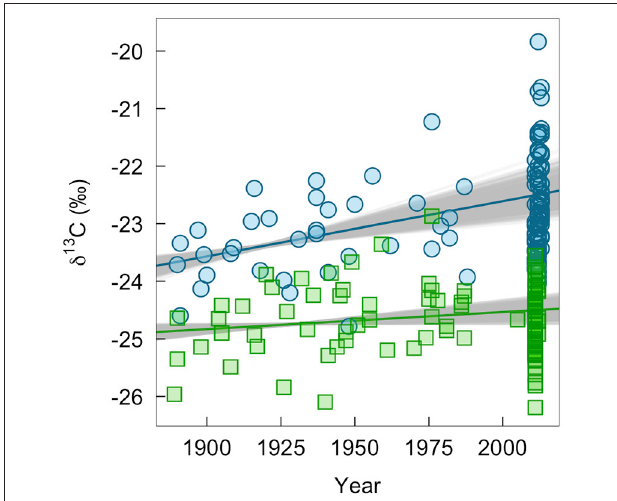
FIGURE 4 | Measured change in δ 13 C-values of bird tissues over time pooled across ages and sexes (claw, blue circles; feathers, green squares). The lines show the mean predicted relationship from linear models based on all historic samples and 1,000 bootstrapped sub-samples of contemporary bird tissues. The gray shows the variation in predicted